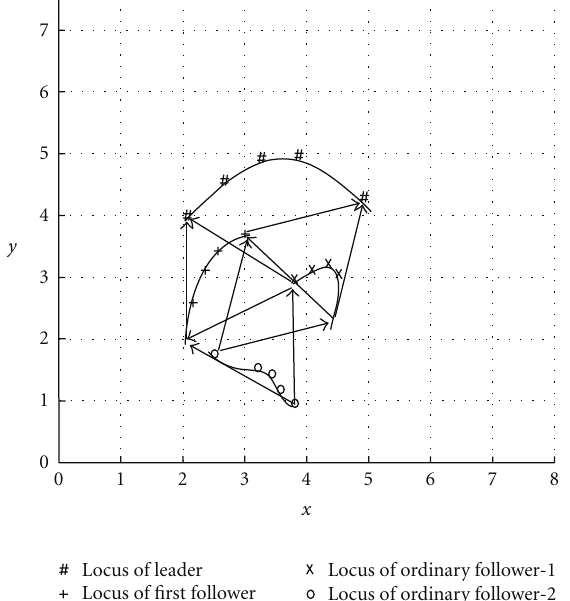
Figure 14: Motion of triangular formation of leader-follower struc- ture, with sinusoidal motion of leader. In this figure during motion of formation, paths of leader, first follower, and ordinary follower are shown. During motion interagent distances are maintained at desired